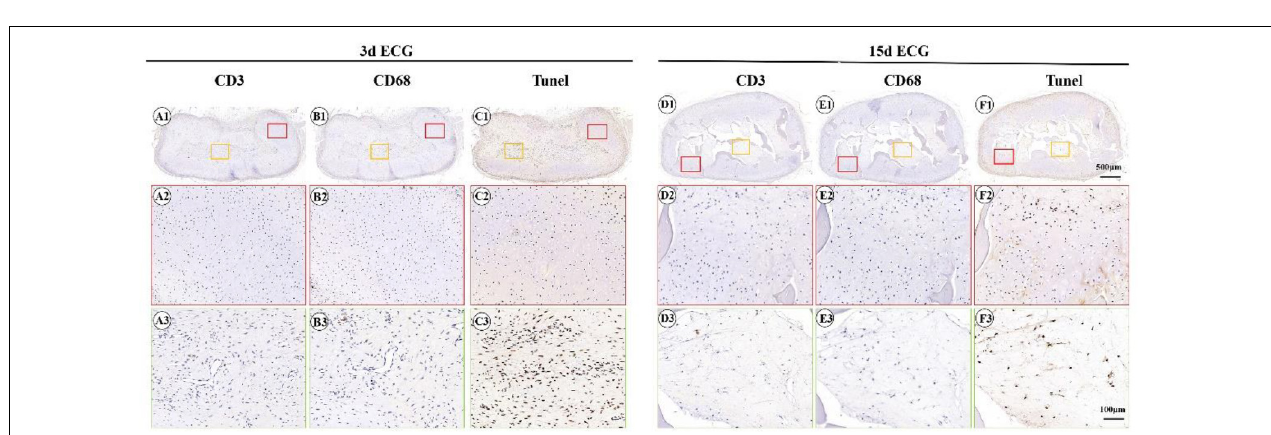
FIGURE 5 | Quantitative evaluations of the cartilage regenerated by goat engineered cartilage gel (ECG) after 12 weeks in vivo . Quantitative analysis of the wet weight (A) , volume (B) , Young’s modulus (C) , total glycosaminoglycan (GAG) (D) , and total collagen (E) in different groups. N-3-12 = the cartilage regenerated by 3 d ECG–decalcified bone matrix (DBM) constructs after 12 weeks in vivo in nude mice; N-15-12 = the cartilage regenerated by 15 d ECG–DBM constructs after 12 weeks in vivo in nude mice; G-3-12 = the cartilage regenerated by 3 d ECG–DBM constructs after 12 weeks in vivo in autologous goats; G-15-12 = the cartilage regenerated by 15 d ECG–DBM constructs after 12 weeks in vivo in autologous goats. * P < 0.05.